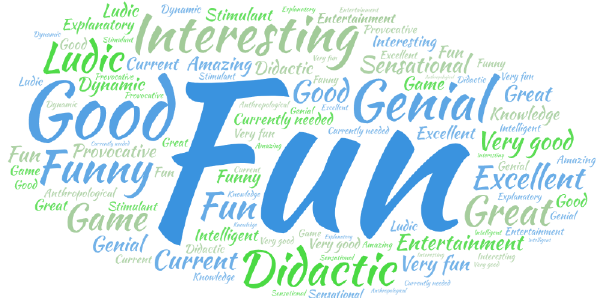
Figure 5. The word cloud shows the main words linked with/describing the play.